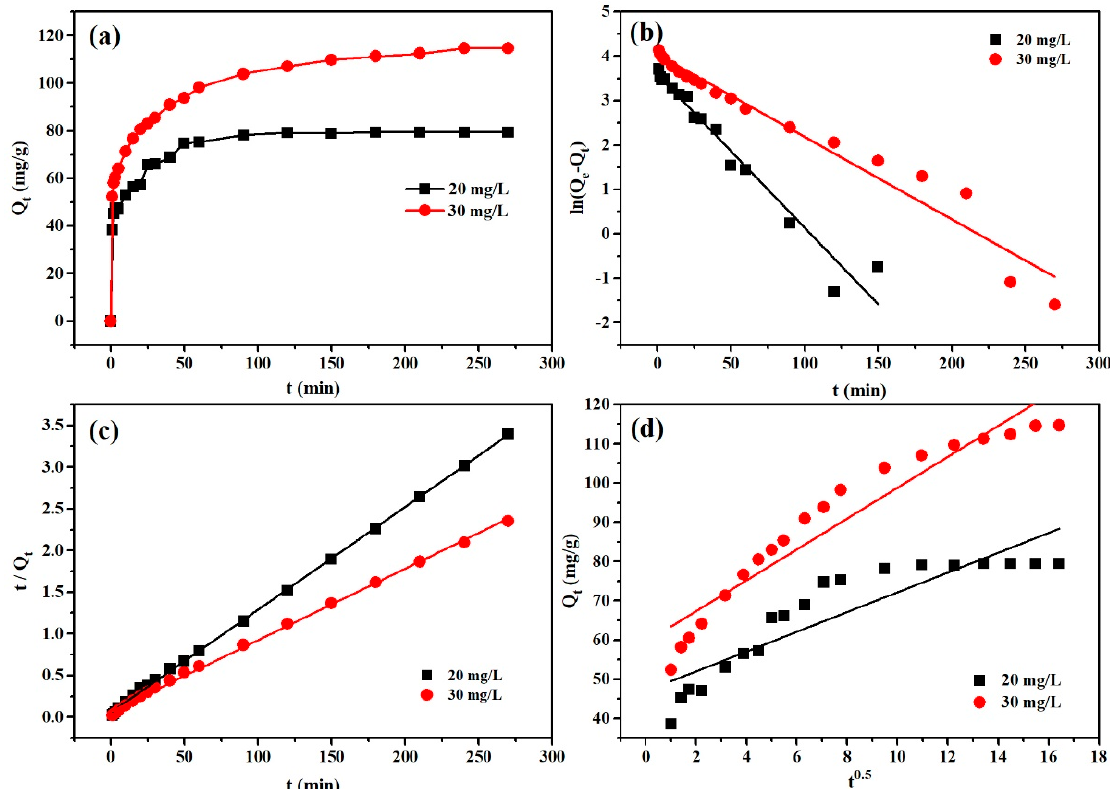
Figure 5. ( a ) Effect of contact time on adsorption of MO by PANI/PSMA at pH 4.0 and 25 °C; ( b ) pseudo-first-order kinetic model plots; ( c ) pseudo-second-order kinetic model plots; ( d ) intraparticle diffusion model plots.